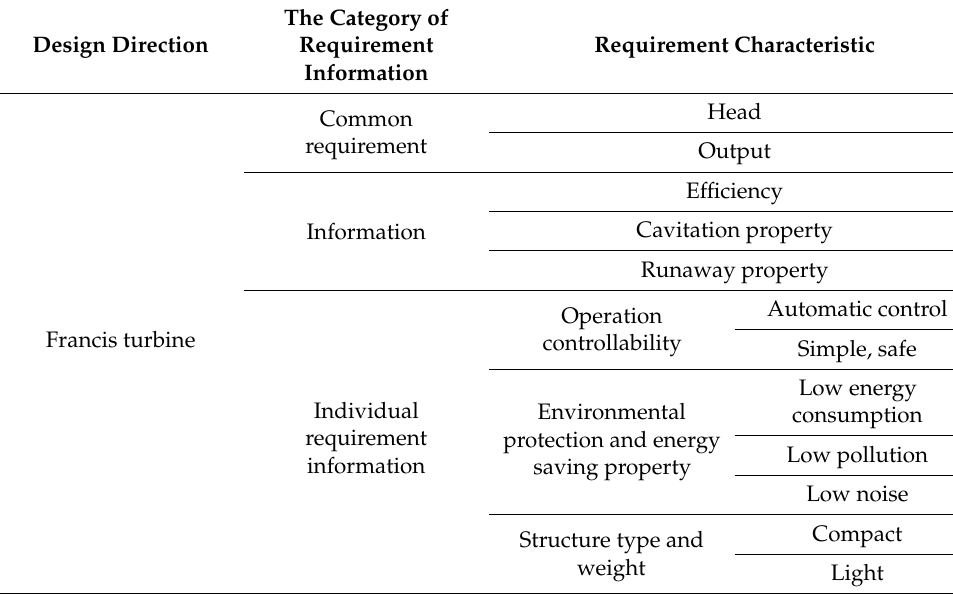
Table 2. The Decomposition of Design Requirement